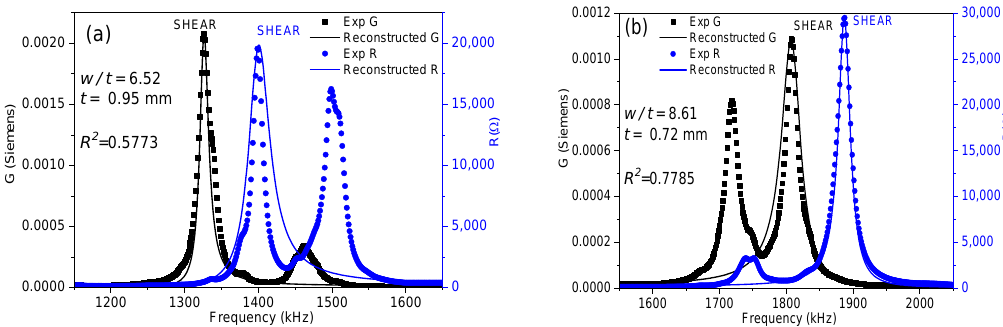
Figure 4. Impedance spectra showing coupled modes (low R 2 ) for the BCZT plate for aspect ratios ( a ) w / t = 6.52; ( b ) w / t = 8.61. Experimental G and R peaks (symbols) are displayed, as well as reconstructed peaks (solid lines).